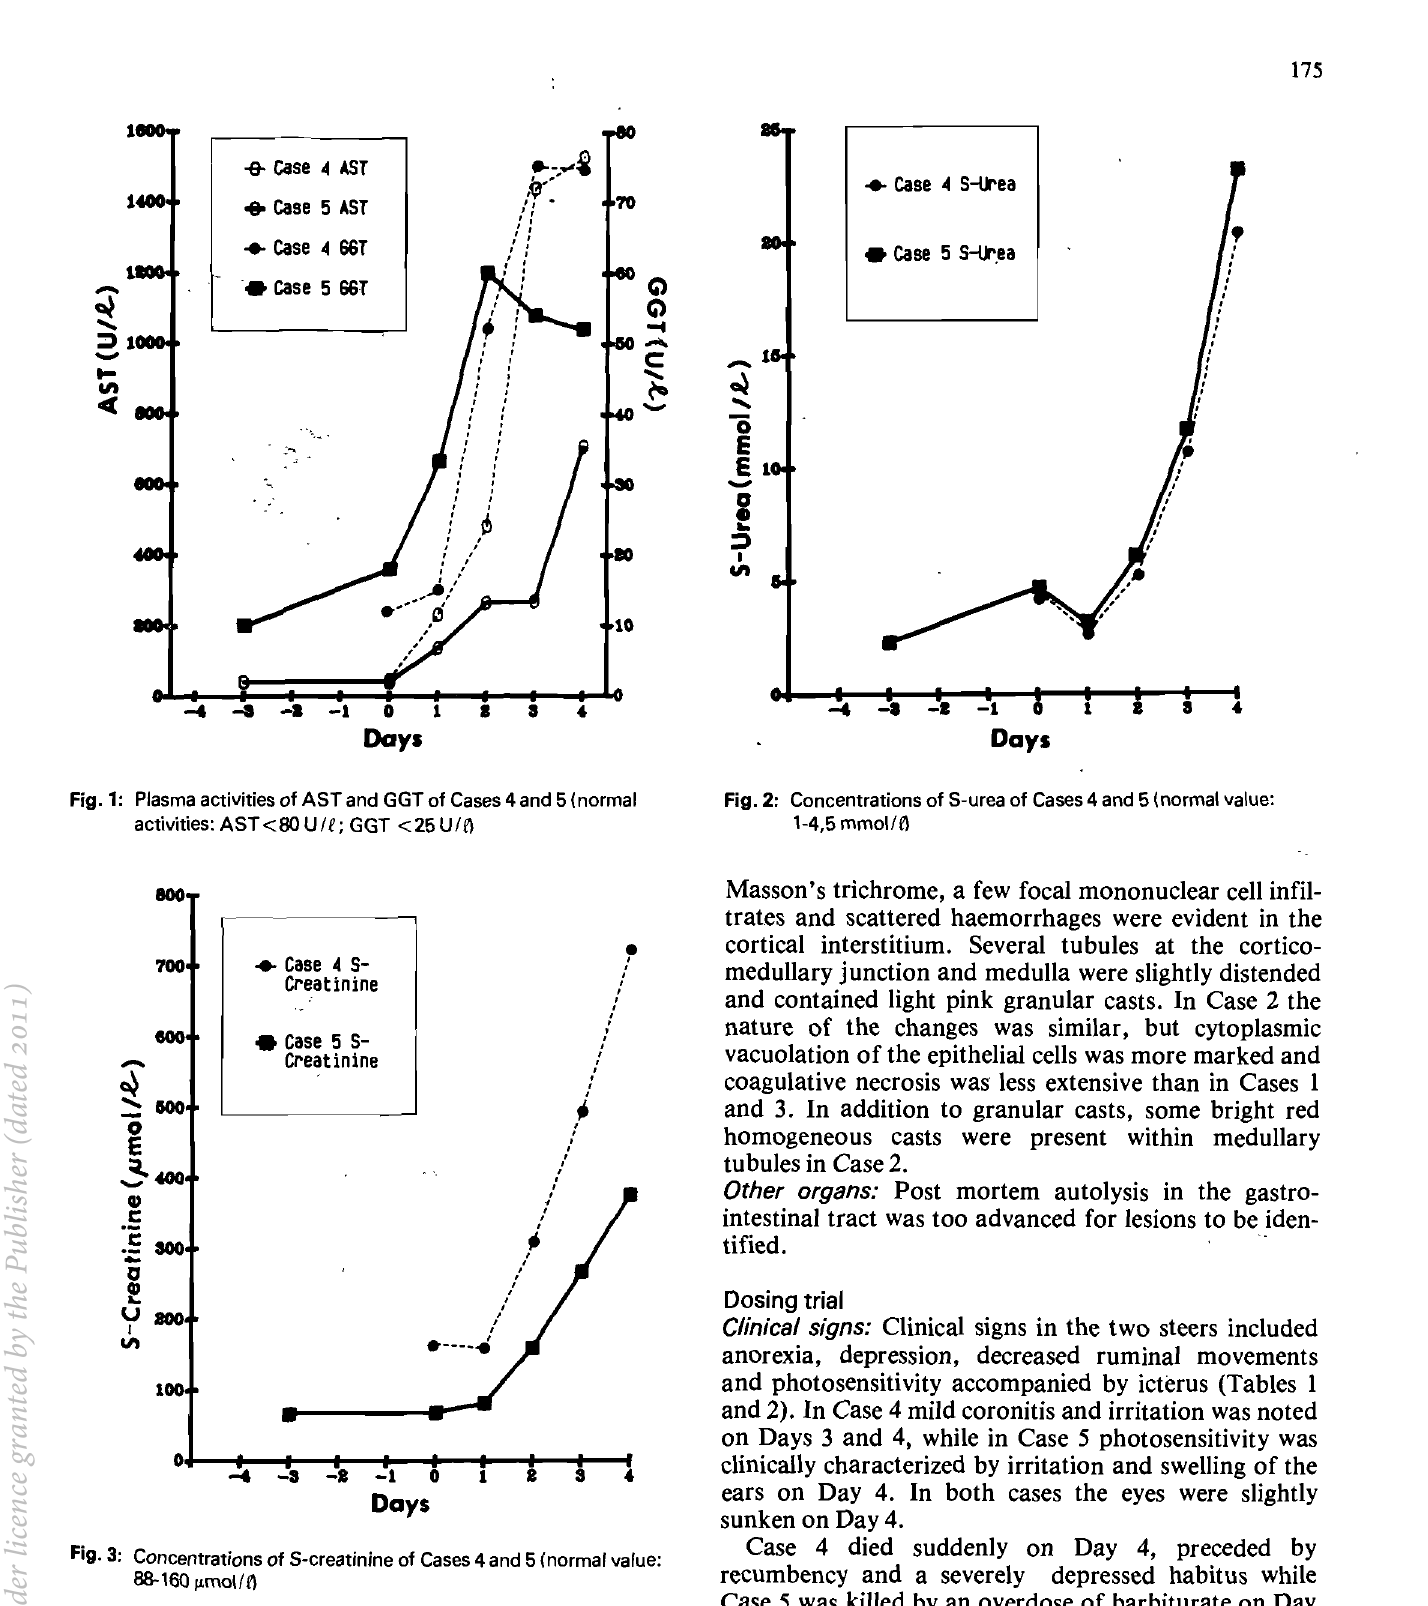
Fig. 3: Concentrations of S-creatinine of Cases 4 and 5 (normal value: 88-160 J.lmollf)